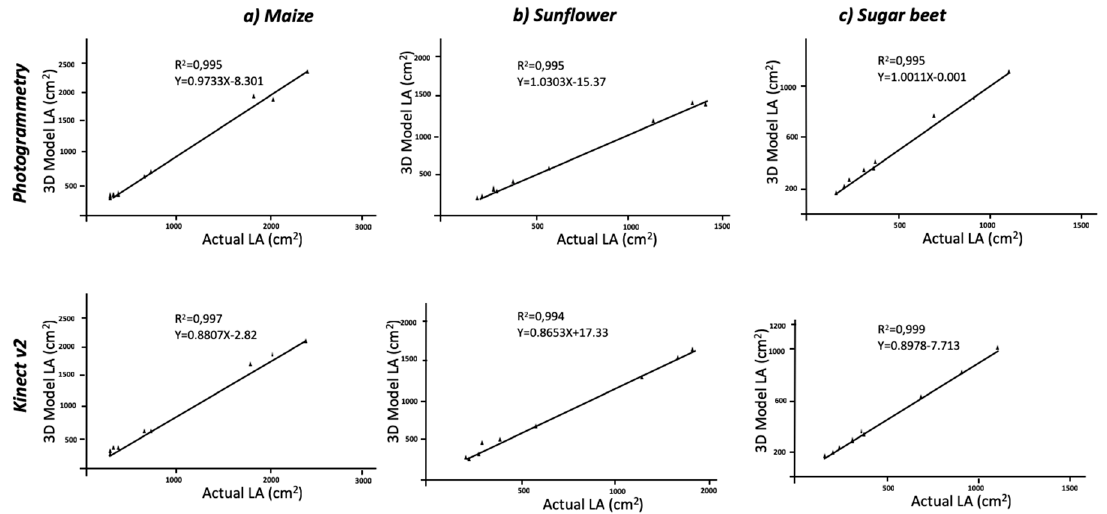
Table 2. Root mean square error (RMSE) and mean absolute percentage error (MAPE) calculated values for photogrammetry and Kinect v2 methods in three different crops.